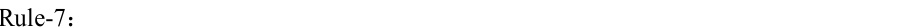
Figure 12. Separate critical vulnerable platforms with specific patterns.